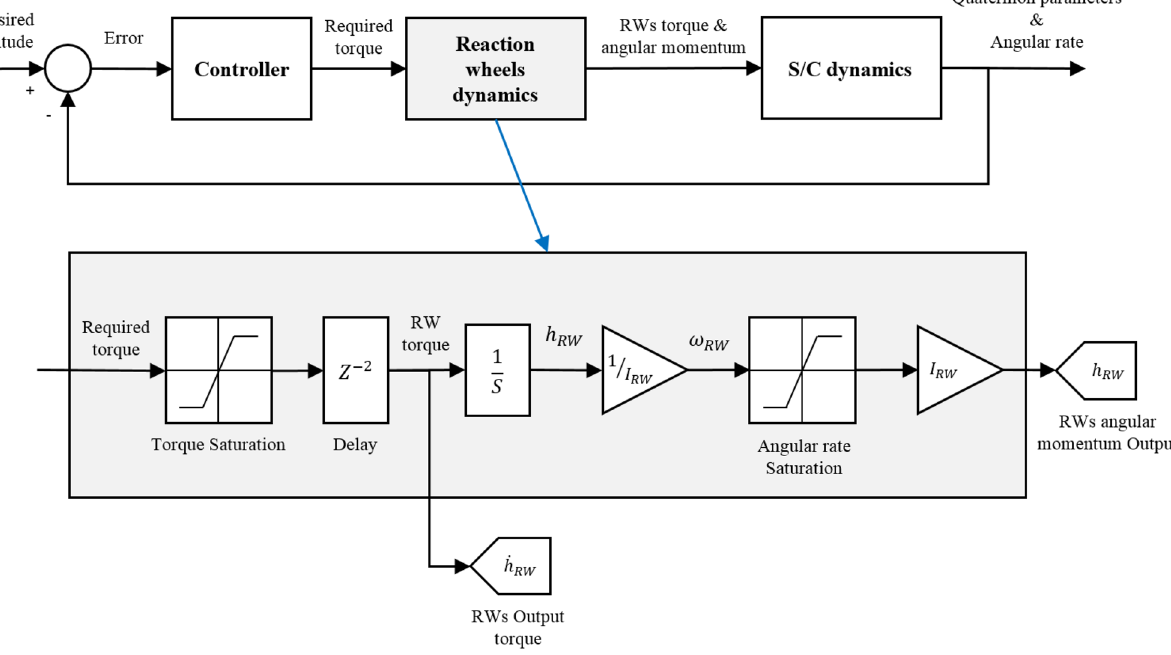
Figure 6. Block diagram of the Reaction